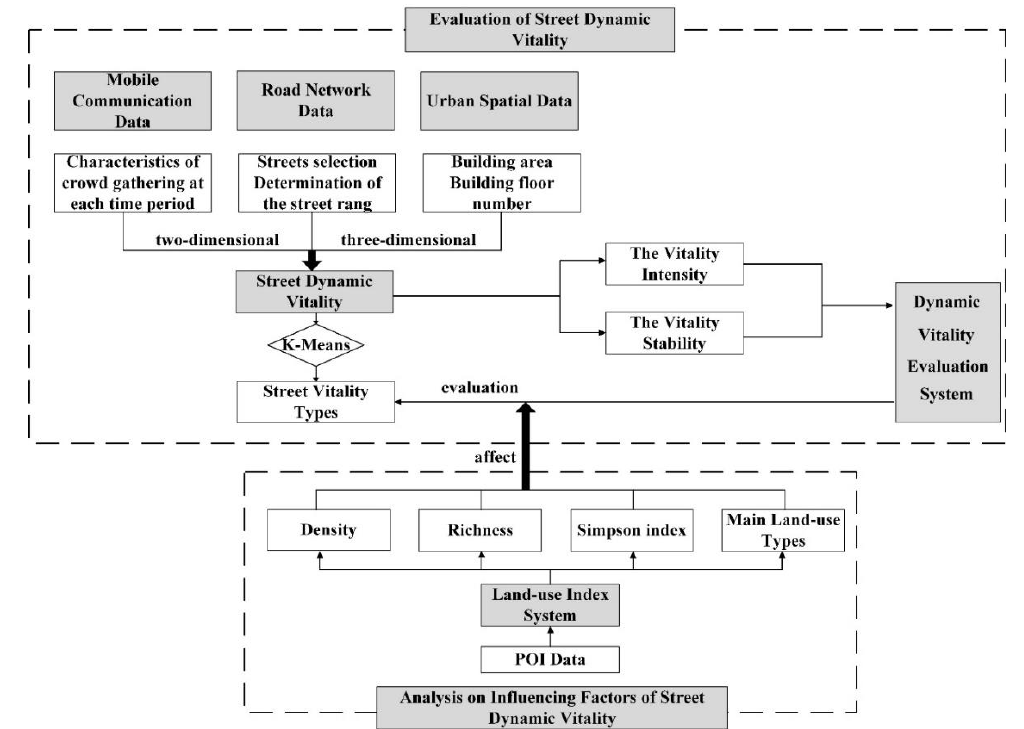
Figure 3. The methodology framework.